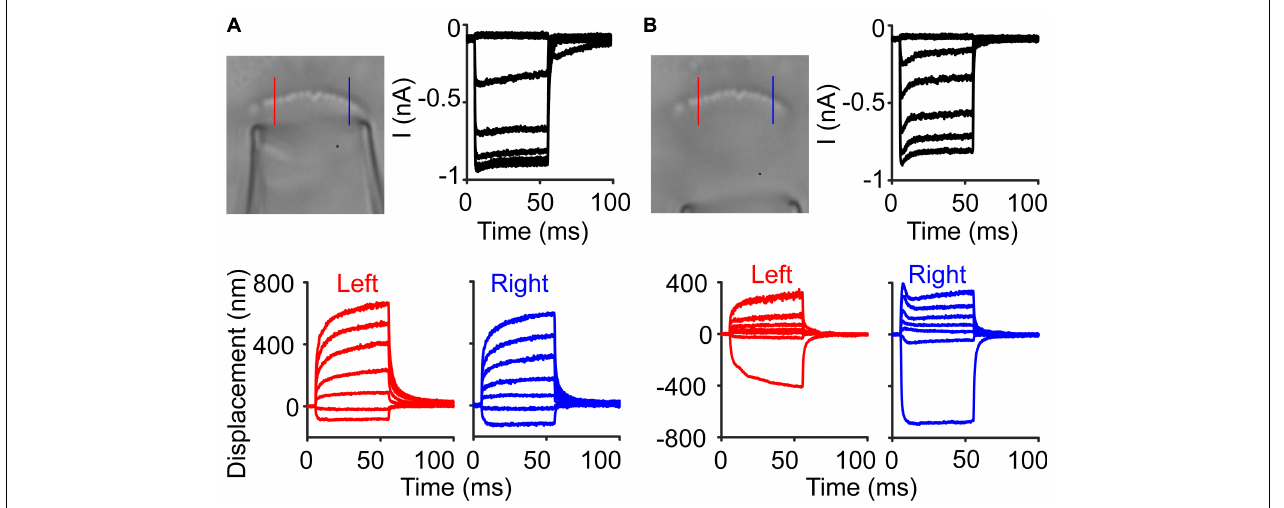
FIGURE 8 | Stimulus artifacts lead to the appearance of current adaptation. (A) An inner hair cell was stimulated with a fluid jet to elicit a current response with little adaptation observed in the current. Lines indicate locations where the hair bundle motion was taken in the raw image. (B) In the same cell, a larger amount of current adaptation was observed, but the hair bundle motion showed that on the right side of the hair bundle, there was a recoil of the hair bundle, causing an artifactual current decline.